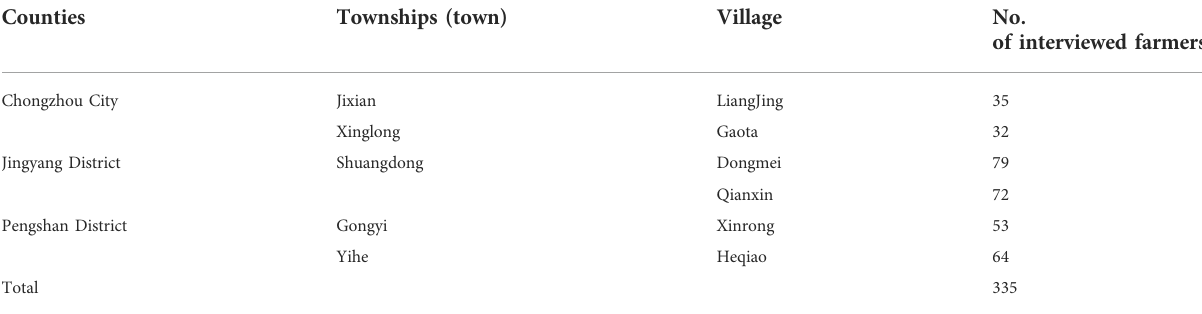
TABLE 2 Distribution of sample data